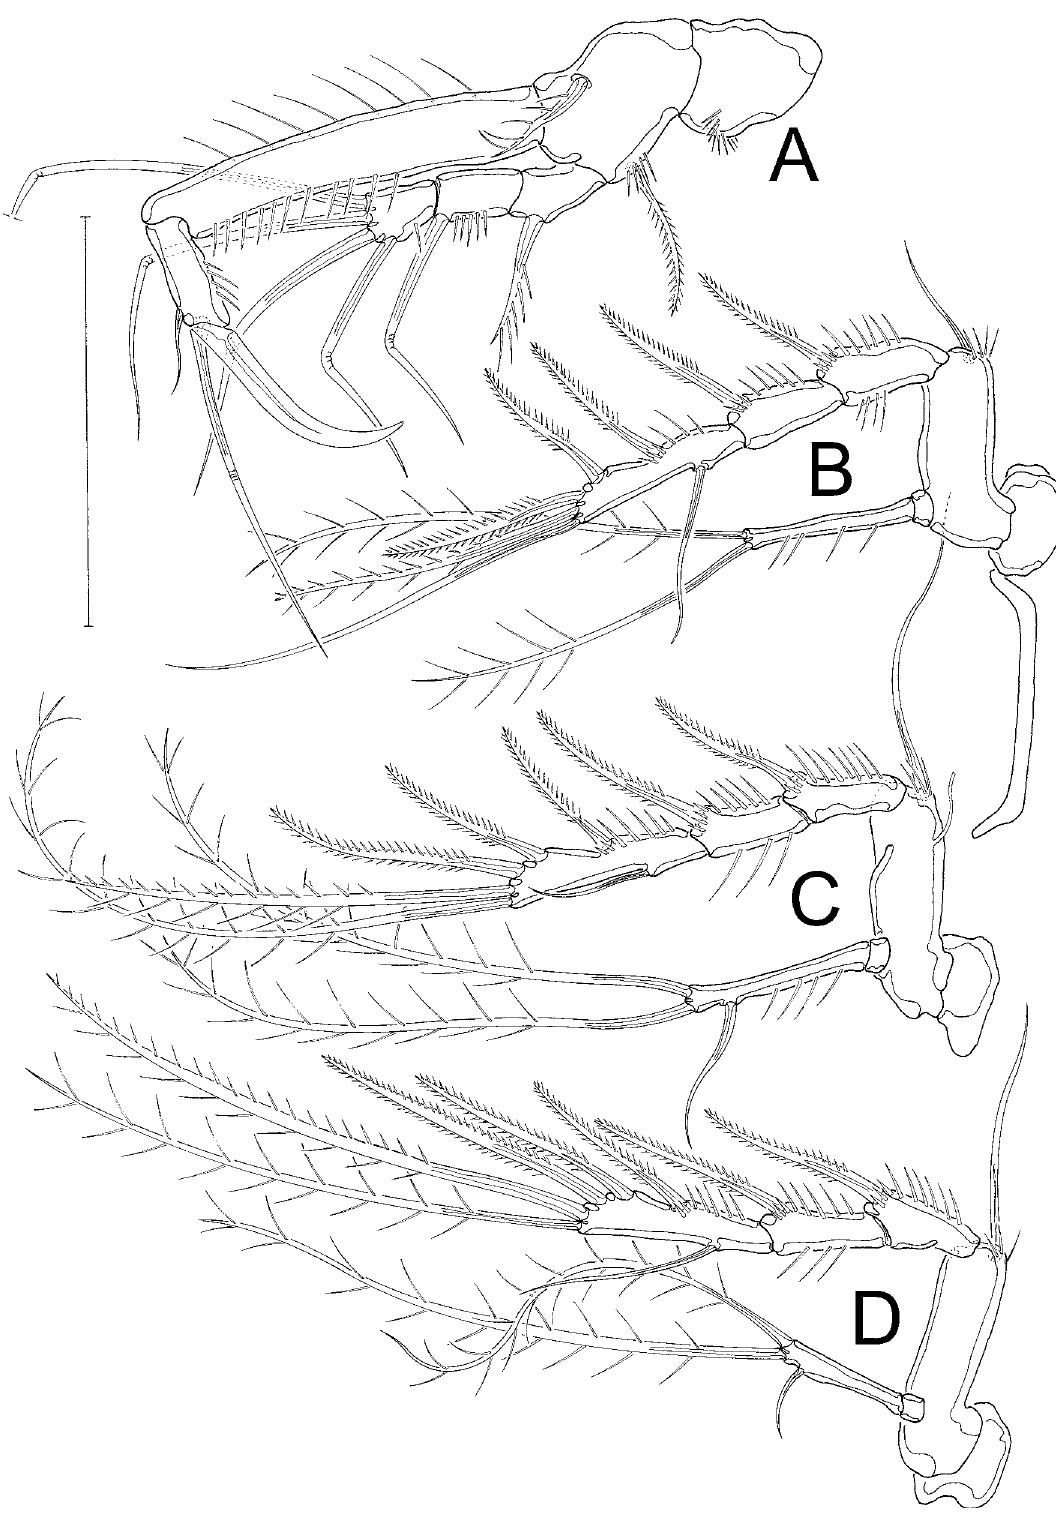
Fig. 5. Laophontodes typicus T. Scott, 1894, ♀ (BMNH 2015.1144–1153-1). A . P1. B . P2. C . P3. D . P4. Scale bar = 50